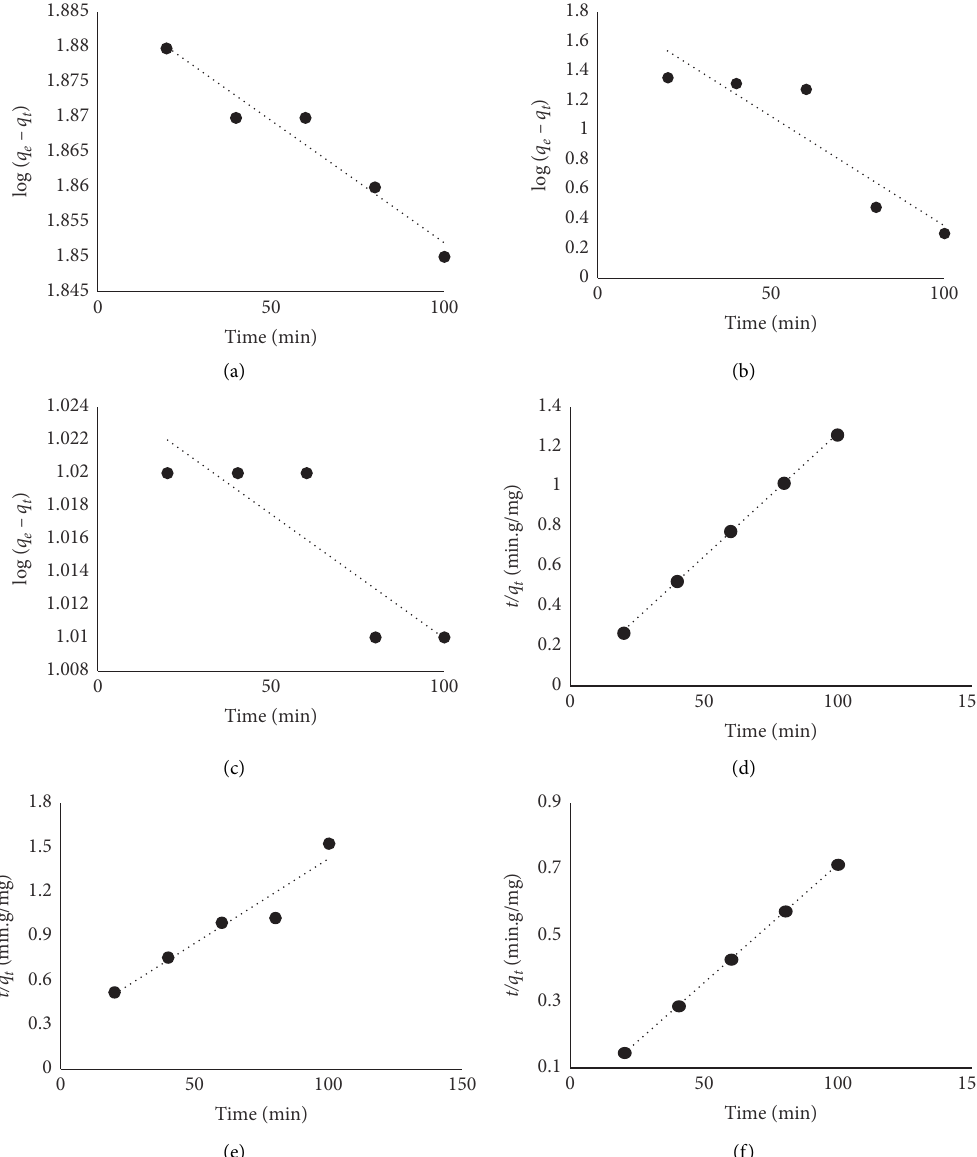
Figure 10: Kinetic models of MB removal by MSNs-Cys: (a–c) pseudo-first-order reactions at pH 1.5, 7, and 8.5, respectively; (d–f) pseudo- second-order reactions at pH 1.5, 7, and 8.5, respectively (150ppm, 25 ° C, and 150rpm). Table 4: Coefficient of pseudo-first-order and pseudo-second-order reactions for MB removal by MSNs-Cys at 150ppm and 25 ° C. pH Parameters